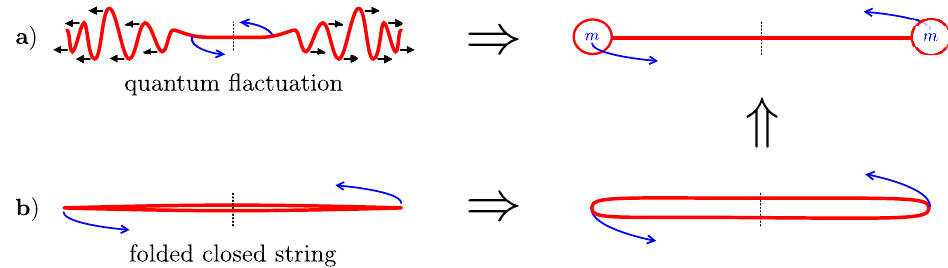
Figure 2 . a) We imagine quantum corrections on the worldsheet. For the rotating string, they experience the centrifugal potential and are pushed to the boundary of the string. The leading effect is making the endpoints of the string massive. b) Imagine a rotating closed string. It has folds, points where the extrinsic curvature diverges. Regularizing it by adding higher derivative terms in the worldsheet action makes the endpoints move slower than the speed of light. The result is again the string with the massive